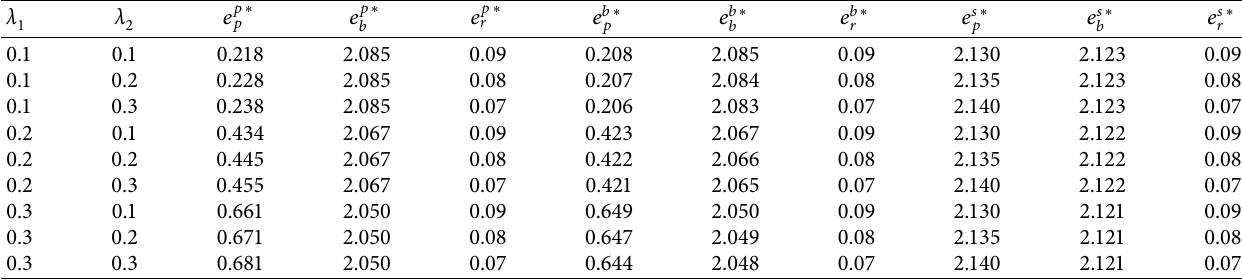
Table 3: Impact of change in λ 1 and λ 2 on the quality of